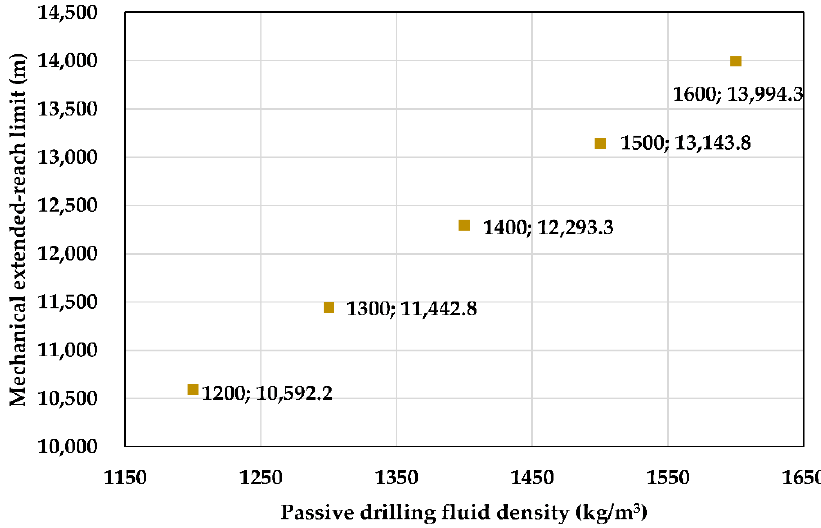
Figure 10. Effect of the passive drilling fluid density on the mechanical extended-reach limit.